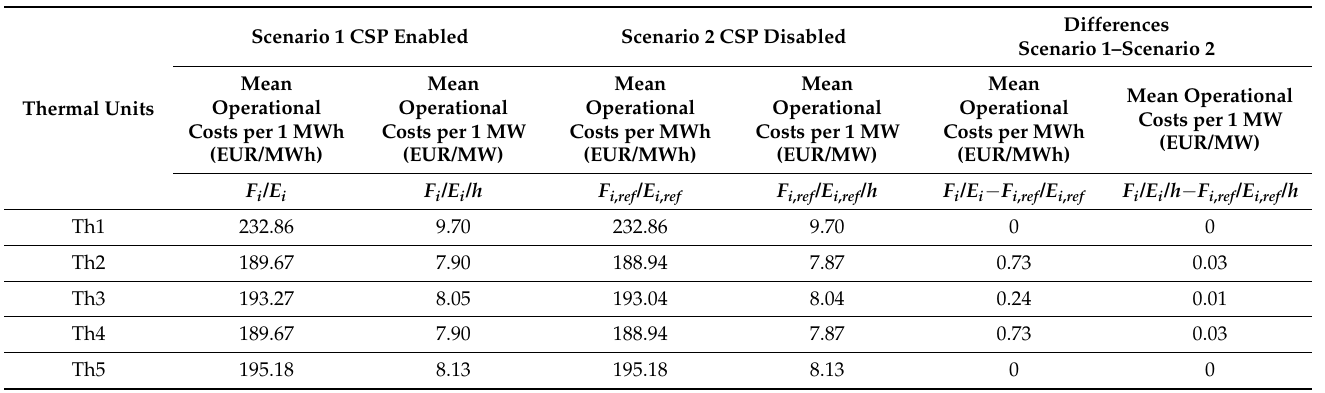
Table 2. Mean Minimal Operational Costs per